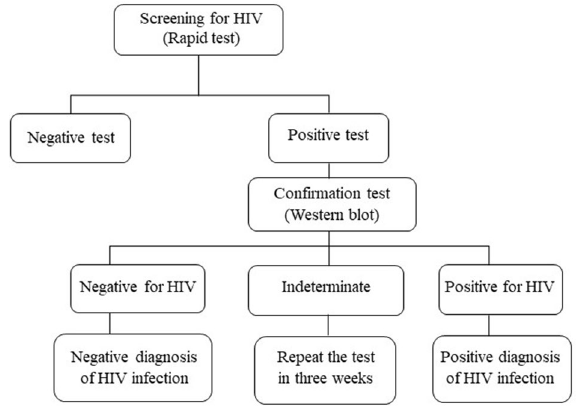
Figure 1. Human immunodeficiency virus diagnostic algorithm in adults, Morocco 17